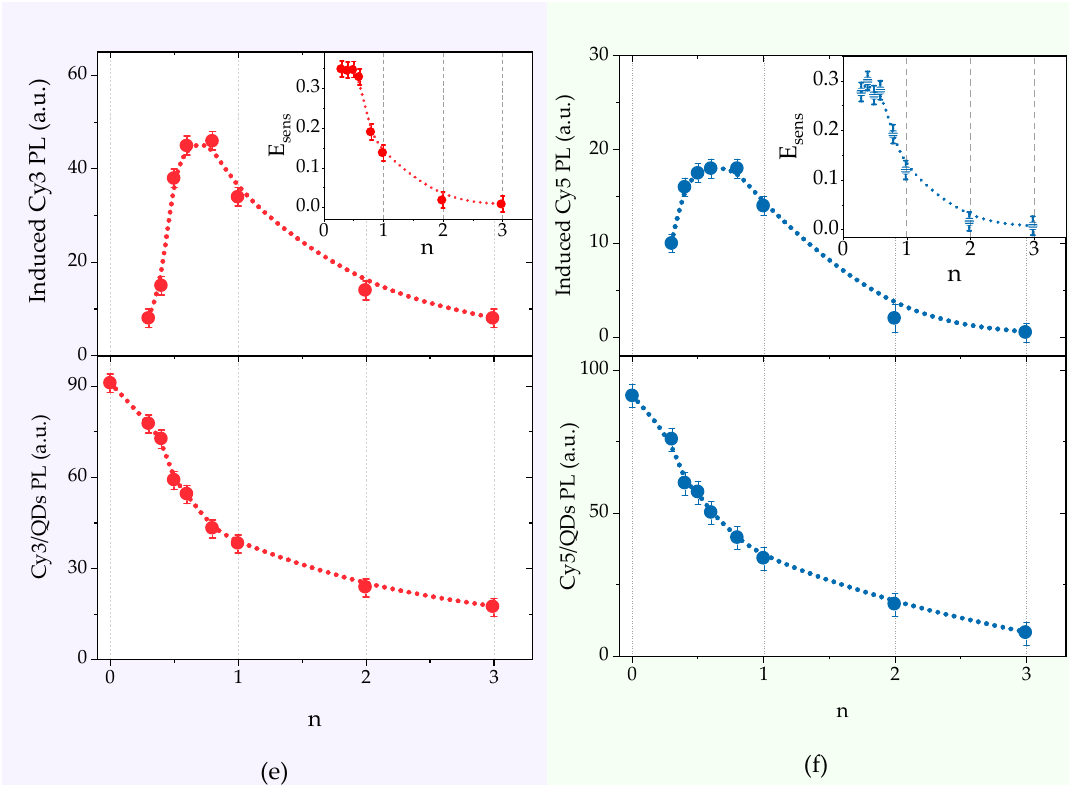
Figure 4. ( a – d ) PL spectra of AIS QDs and cyanine dye complexes at different molar ratio of dyes and QDs, n = C dye /C QD . ( a ) Förster resonance energy transfer (FRET) ‐ induced PL spectra at 405 nm excitation of QDs/Cy3 complexes; ( b ) FRET ‐ induced PL spectra at 405 nm excitation of QDs/Cy5 complexes; ( c ) intrinsic PL at 520 nm excitation of QDs/Cy3 complexes; ( d ) intrinsic PL at 620 nm excitation of QDs/Cy5 complexes; ( e , f ) intensity of FRET ‐ induced PL of acceptor (Cy3/Cy5) at 405 nm excitation as a function n = C dye /C QD (top), donor (QDs) quenching in the presence of acceptor (Cy3/Cy5) (bottom) , FRET efficiency, estimated using Equation (4) for complexes QDs/Cy3 andQDs/Cy5, respectively (top, inset).